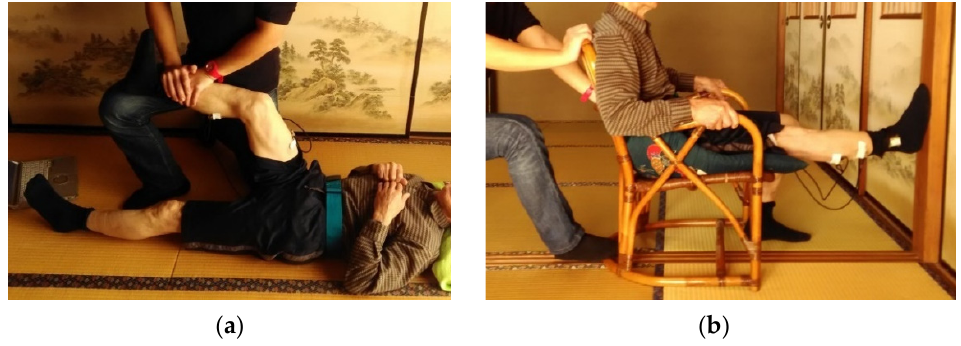
Figure 5. MVC measurement method: ( a ) measurement for the thigh ( b ) measurement for the calf. Finally, in T5 the body measurements, weight, height, length of the calf, and length